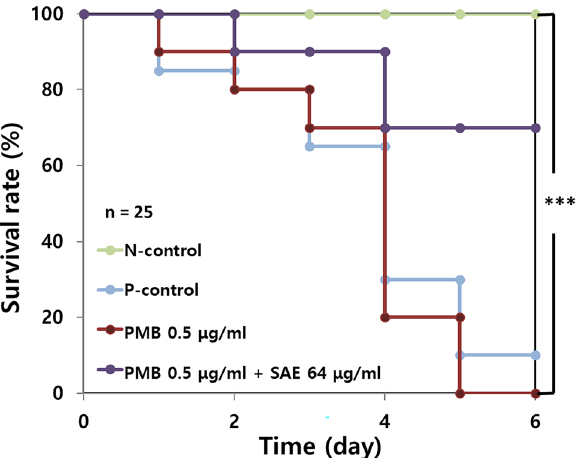
Figure 3. In vivo synergistic effect using G. mellonella . G. mellonella was divided into two groups: (1) PMB alone and (2) PMB and SAE. A total of 25 Galleria mellonella larvae per condition were infected with the A. baumannii ATCC 17978 to compare their pathogenicity in vivo. The survival rate of each group was assessed for 5 days. Statistical analysis was performed using Student’s t -test (* P < 0.05, *** P <